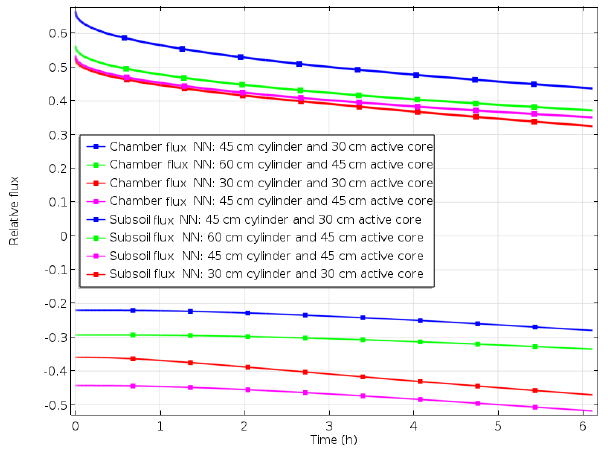
Figure 5. Impact of the depth of the active core (representing depth of 15 N labelling) and/or length of cylinder on relative surface and subsurface fluxes (scenarios B_30_30, B_ 45_ 30, B_45_45 and B_60_45.